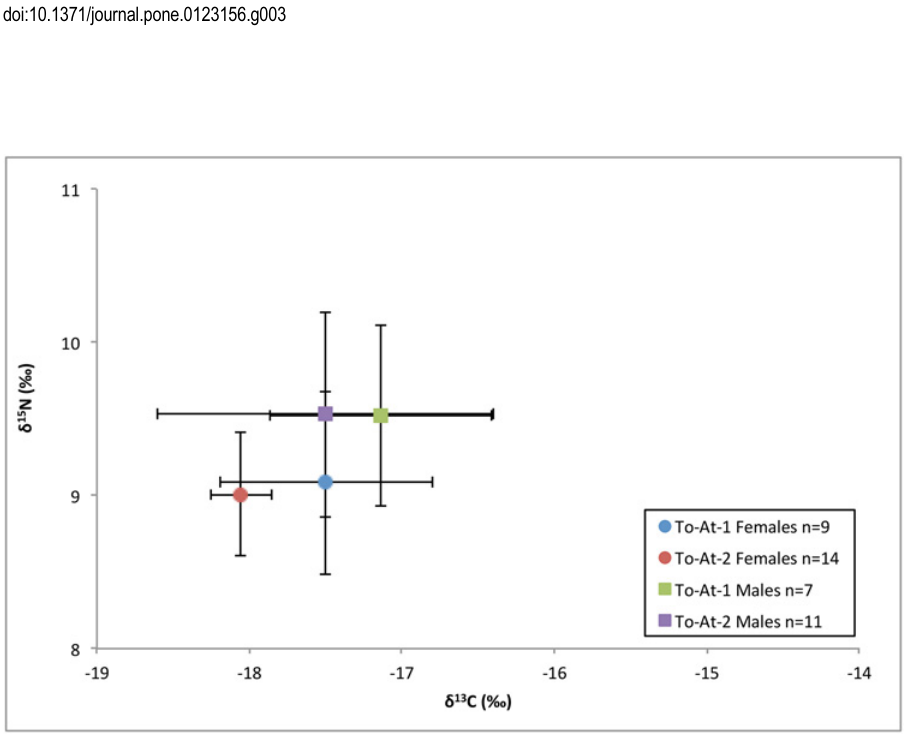
Fig 4. Mean ( ± 1SD) δ 13 C and δ 15 N results for sex and burial mound.